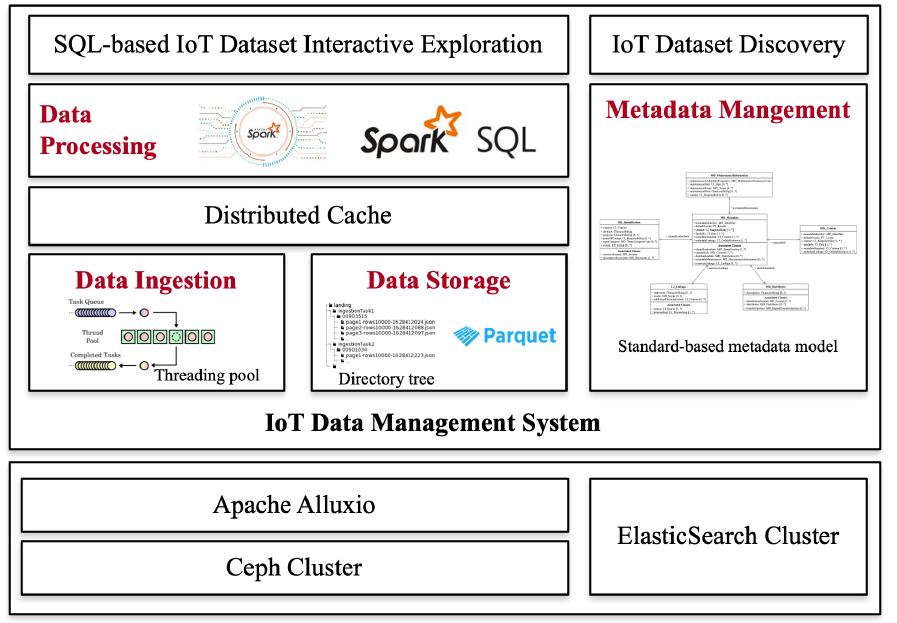
Figure 2. The architecture of the proposed IoT data management